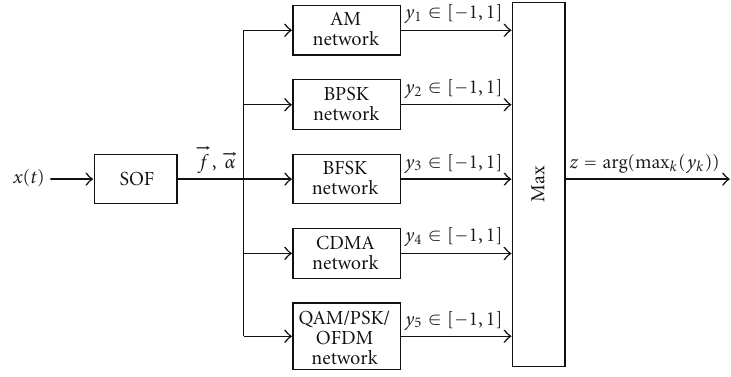
Figure 8: SOF system